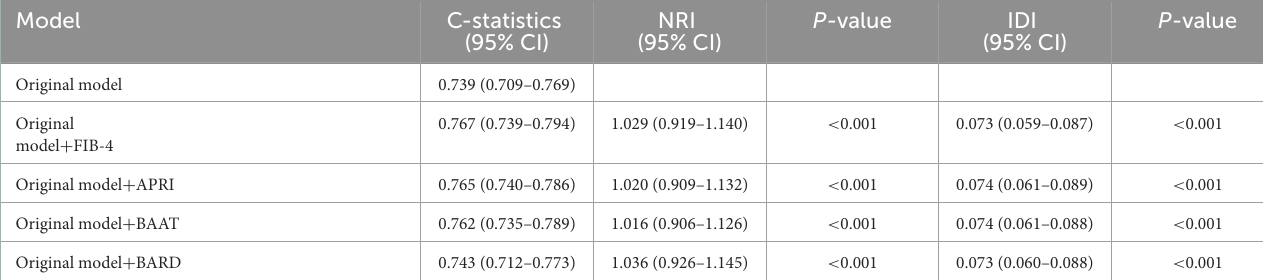
TABLE 3 Discrimination and reclassification for CKD with the addition of LFSs to the traditional risk factors